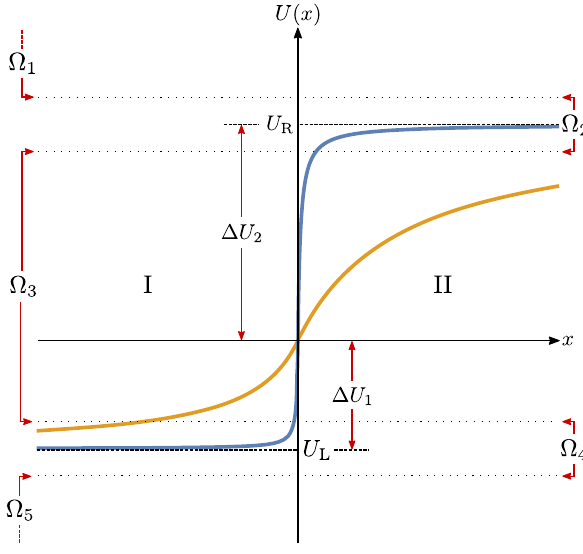
Fig. 2 Potentialenergies of an electron U ( x ) incriticalinverse-square electric fields, corresponding to a “smooth” potential step (solid yellow line) and a “steep” potential step (solid blue line), both with the same asymptotic values U L / R . The smaller (larger) the value of the length scales ξ j , the steeper (the smoother) the potential step. In both curves, ξ > ξ 2